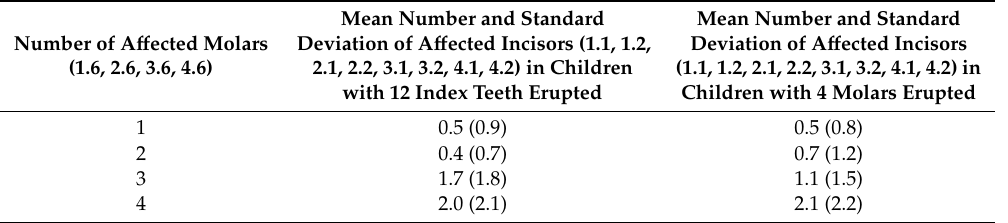
Table 5. Number of a ff ected molars and incisors in hypomineralization lesions in eight-year-olds classified into